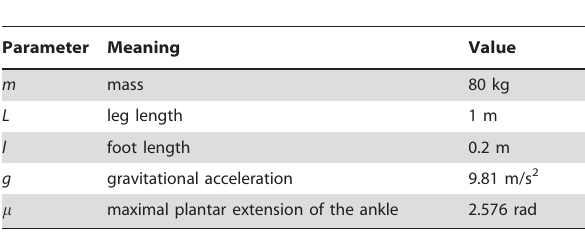
Table 1. Parameter values for the